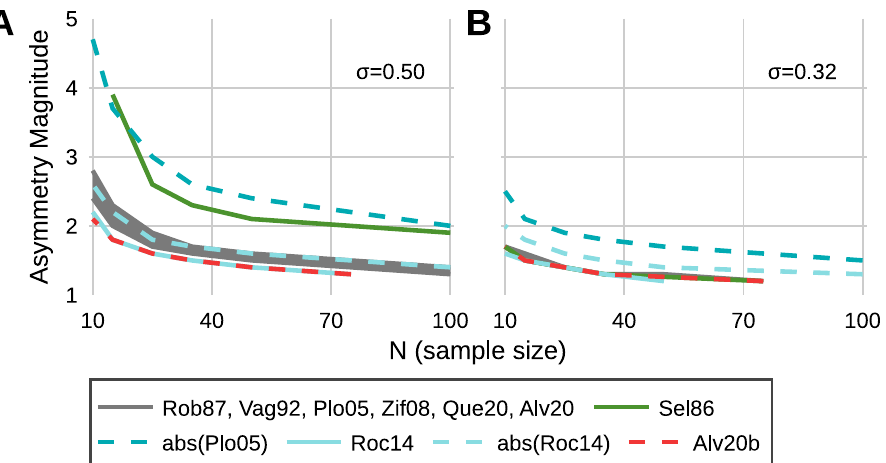
Fig 2. Minimum sample size to achieve sufficient power (80%). Shown at a variability of (A) 0.50 and (B) 0.32. The maximum and minimum sample tested were 100 and 10, respectively. Lower asymmetry magnitude and smaller N (i.e. closer to the bottom left corner) represents higher sensitivity.